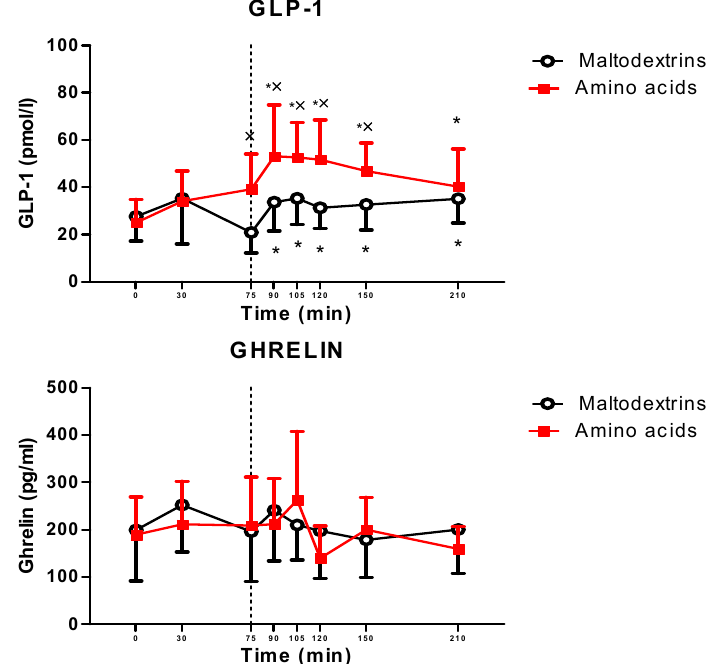
Figure 2. Changes in circulating levels of glucagon-like peptide type 1 (GLP-1 (top panel)) and ghrelin (bottom panel) in obese adolescents after a fixed-dose lunch (completely consumed within 15 min starting at T75), administered with amino acid mix (L-arginine, L-leucine, L-glutamine, and L-tryptophan) or placebo (maltodextrins) at T0. See the text for further details. Values are expressed as means ± standard deviations (SDs). The number of subjects was 14. * p < 0.05 vs. the corresponding T0 value; × p < 0.05 vs. the value in the maltodextrin-treated group at the corresponding time point. A two-way ANOVA with repeated measures (with the two factors time and group and the interaction time × group) followed by the post hoc Tukey’s test was used.